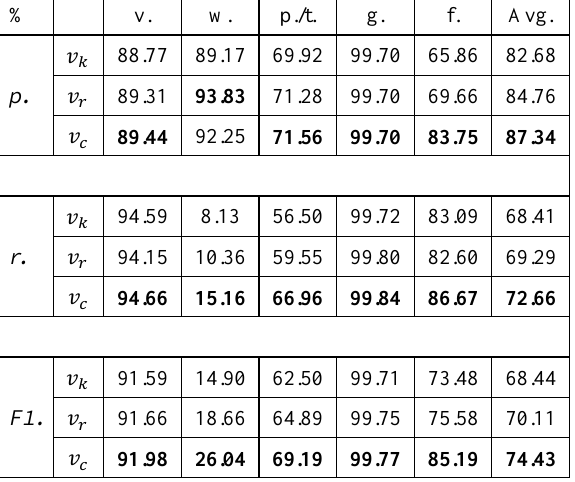
Table 2. Comparisons of evaluation values ( p. : precision, r. : recall, F1. : F1-score) by proposed method on three adaptive neighborhoods (v.: vegetation , w.: wire , p./t.: pole/tree-trunk , g.: ground , f.: facade ).